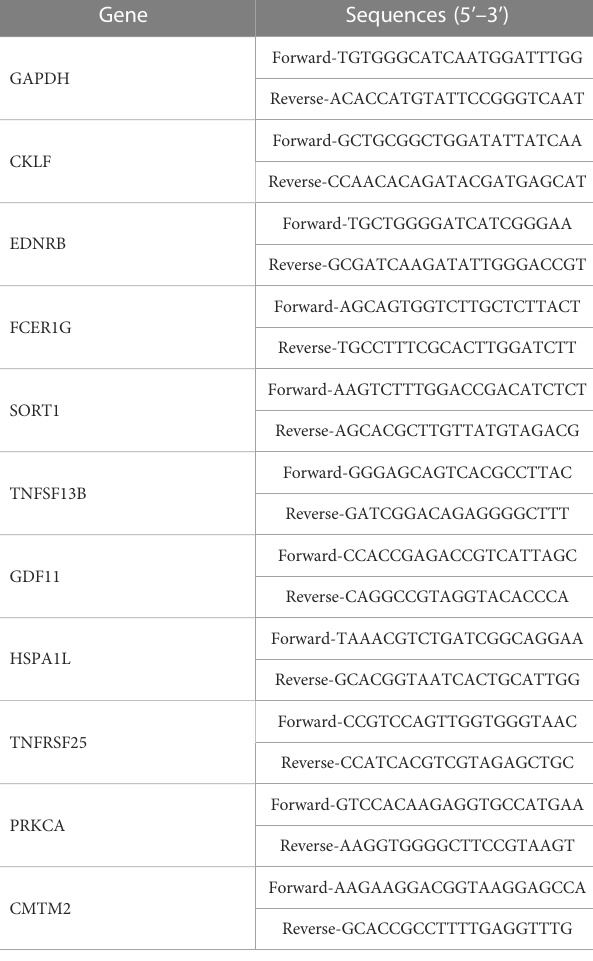
TABLE 1 Primers used for